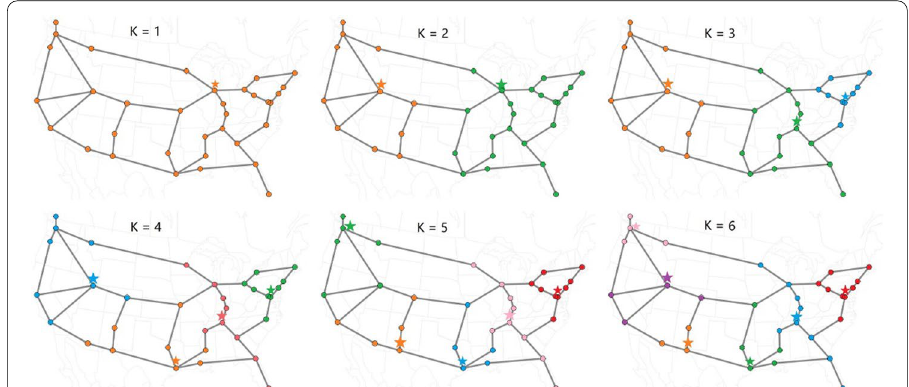
Fig. 3 The position distribution of the controllers (from 1 to 6). The distribution of controllers on the OS3E topology when the number of controllers is from1 to